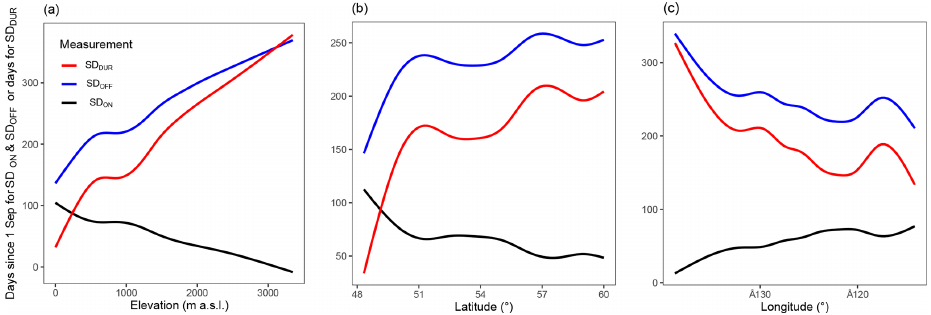
Figure 8. Three-panel plot of the influence of elevation (a) , latitude (b) , and longitude (c) on the mean MODIS-derived value at each random sample point of SD ON (black line, in days since 1 September), SD OFF (black blue, in days since 1 September), and SD DUR (red line, in